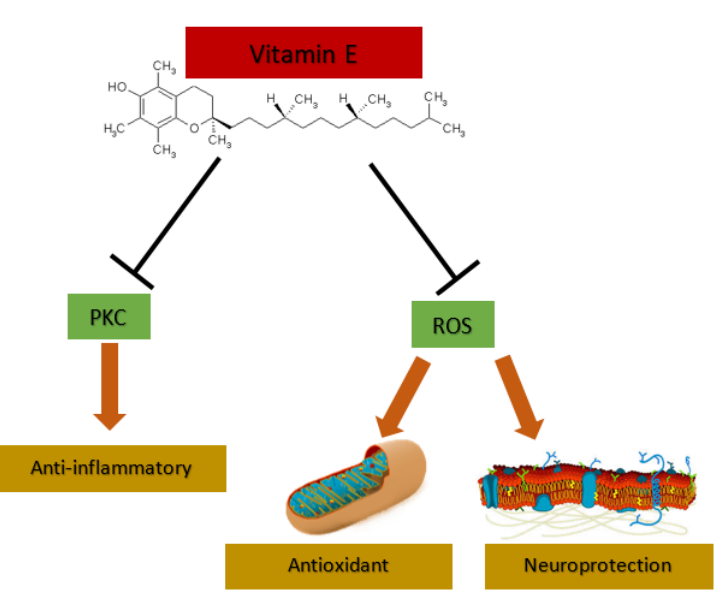
Figure 2. Vitamin E effects. Vitamin E can act as anti-inflammatory through protein kinase C (PKC) inhibition and has antioxidant and neuroprotection properties through the attack to reactive oxygen species (ROS).